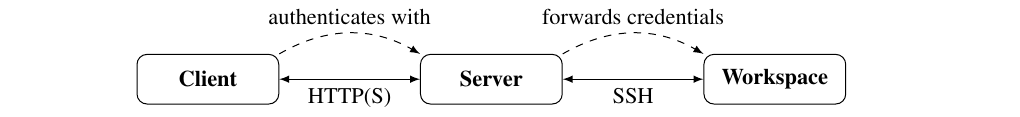
Figure 1: Schema of the three application parts and the client’s authentication interac- tions